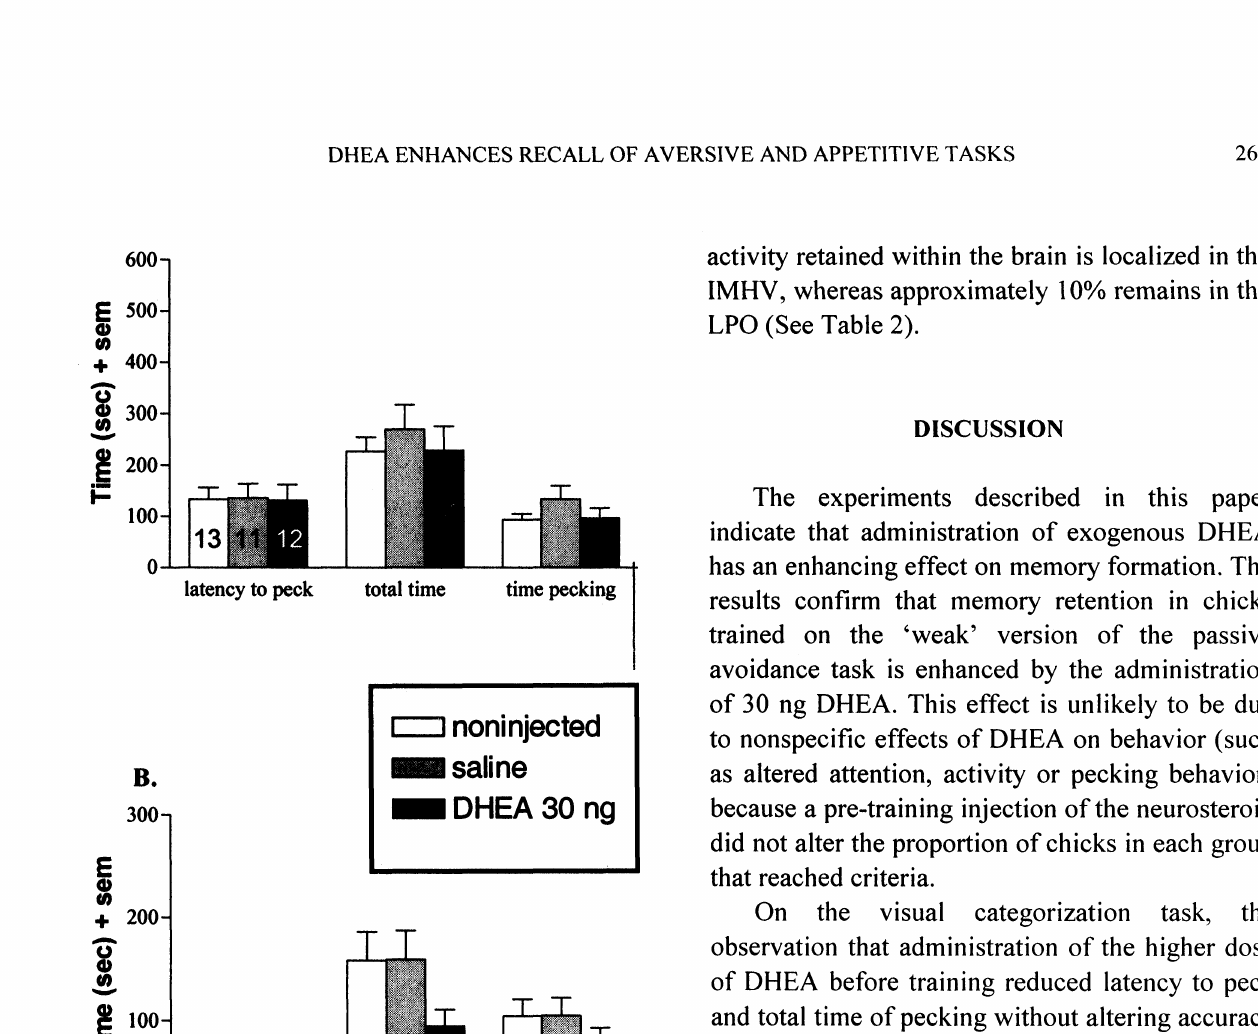
Fig. 5: Effects of a bilateral injection of DHEA (30 ng, solid bars) into the IMHV 5 min pretraining on latency to peck and total time spent completing training (A) and testing (B) on the beadfloor task. The data are compared with those from chicks injected with saline (shaded bars) and a non-injected group of chicks (open bars). The total time spent pecking (total time minus latency) is also presented for training (A) and testing (B). Data are presented as in Fig. 3. * indicates significant differences between treatments on that measure P < 0.05. n values vary and are given in the appropriate